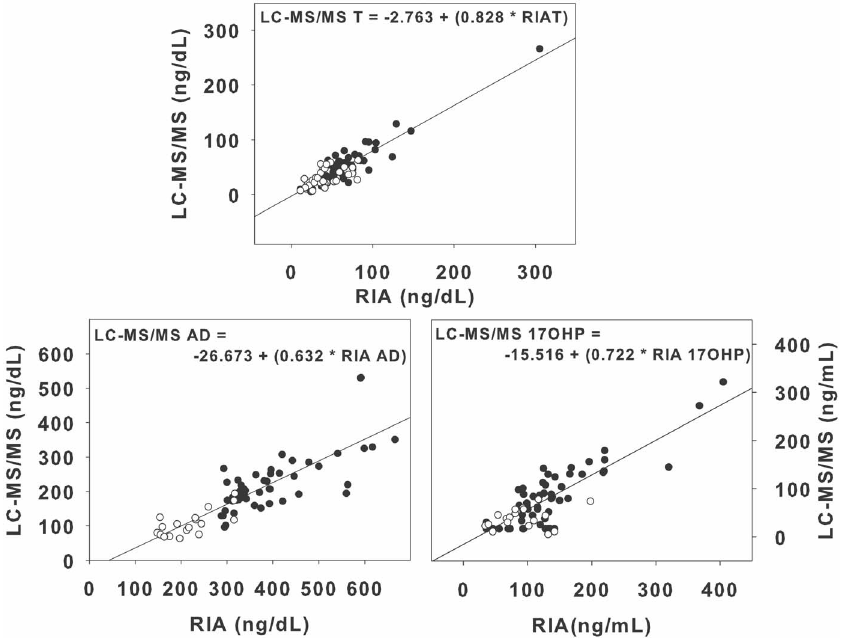
Figure 2. Hormone Levels Assayed Using LC-MS/MS and RIA. Testosterone (T), androstenedione (AD) and 17OH progesterone (17OHP) levels in individual subjects with PCOS (black circles) and controls (white circles) as measured in an RIA and LC-MS/MS. Linear regression is plotted for each hormone. Testosterone, androstenedione and 17-hydroxyprogesterone levels are consistently higher using the RIA.